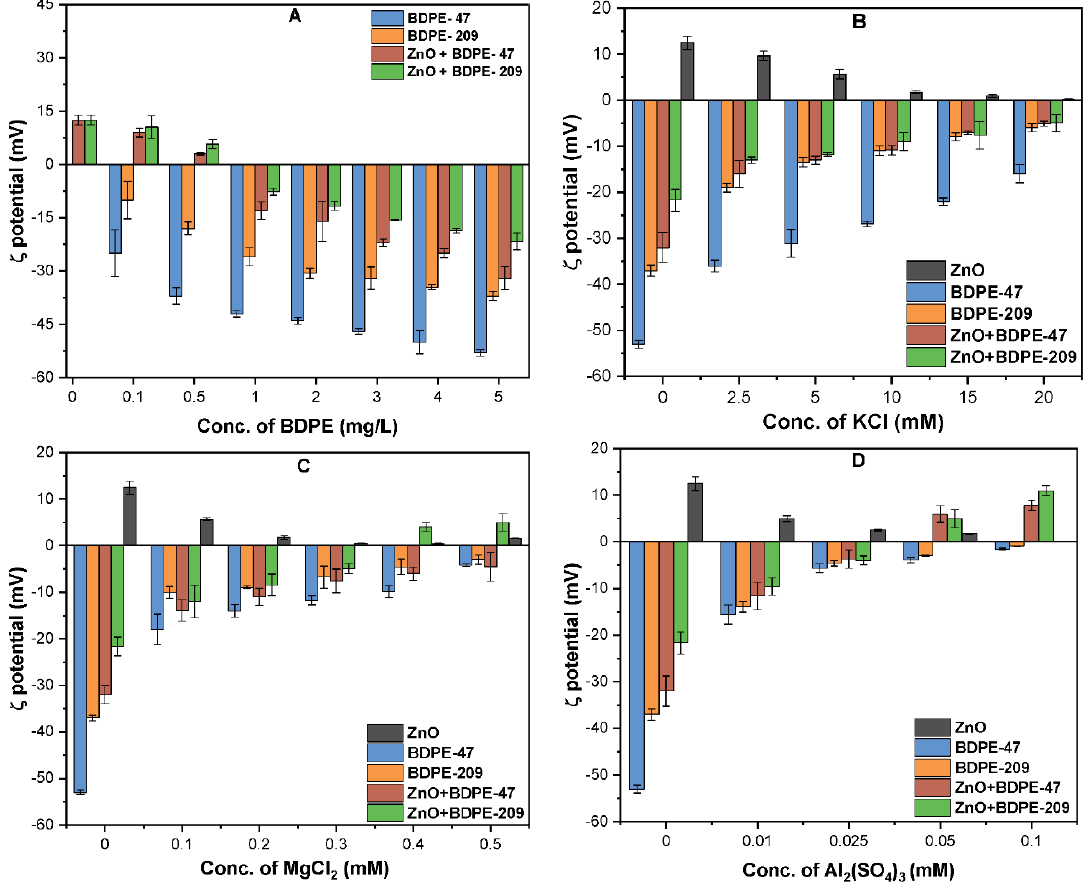
Figure 2. ( A ) ζ potential of ZnO NPs with polybrominated diphenyl ethers (PBDPEs) ((0–5) mg/L) in DI water. ζ potential of BDPEs and ZnO NPs coated with (5 mg/L) PBDPEs in the presence of ( B ) KCl; ( C ) MgCl 2 , and ( D ) Al 2 (SO 4 ) 3 electrolytes.